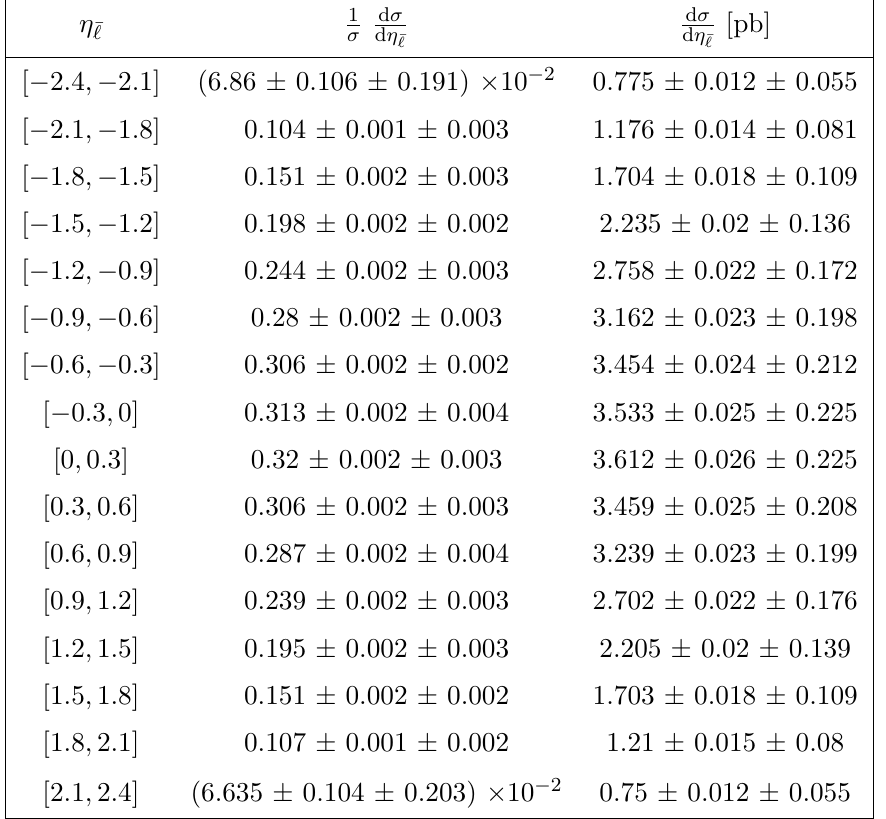
Table 34 . The measured di(cid:11)erential cross section and bin boundaries for each bin of the normalized and absolute measurements of the tt di(cid:11)erential cross section at particle level in the (cid:12)ducial phase space as a function of (cid:17) (cid:22) are ‘